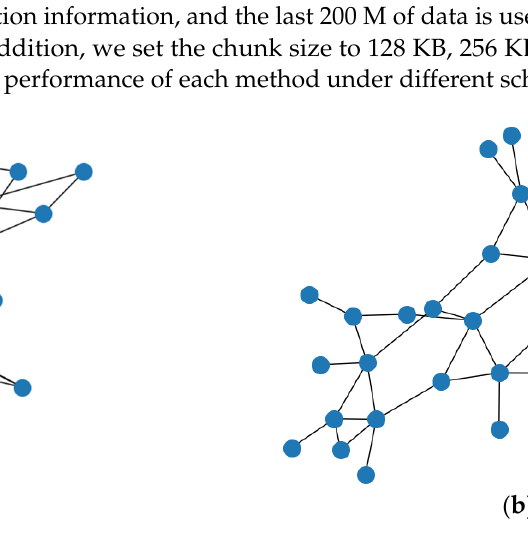
Figure 11. Simulation topology 2: ( a ) BT North America; ( b ) GEANT.